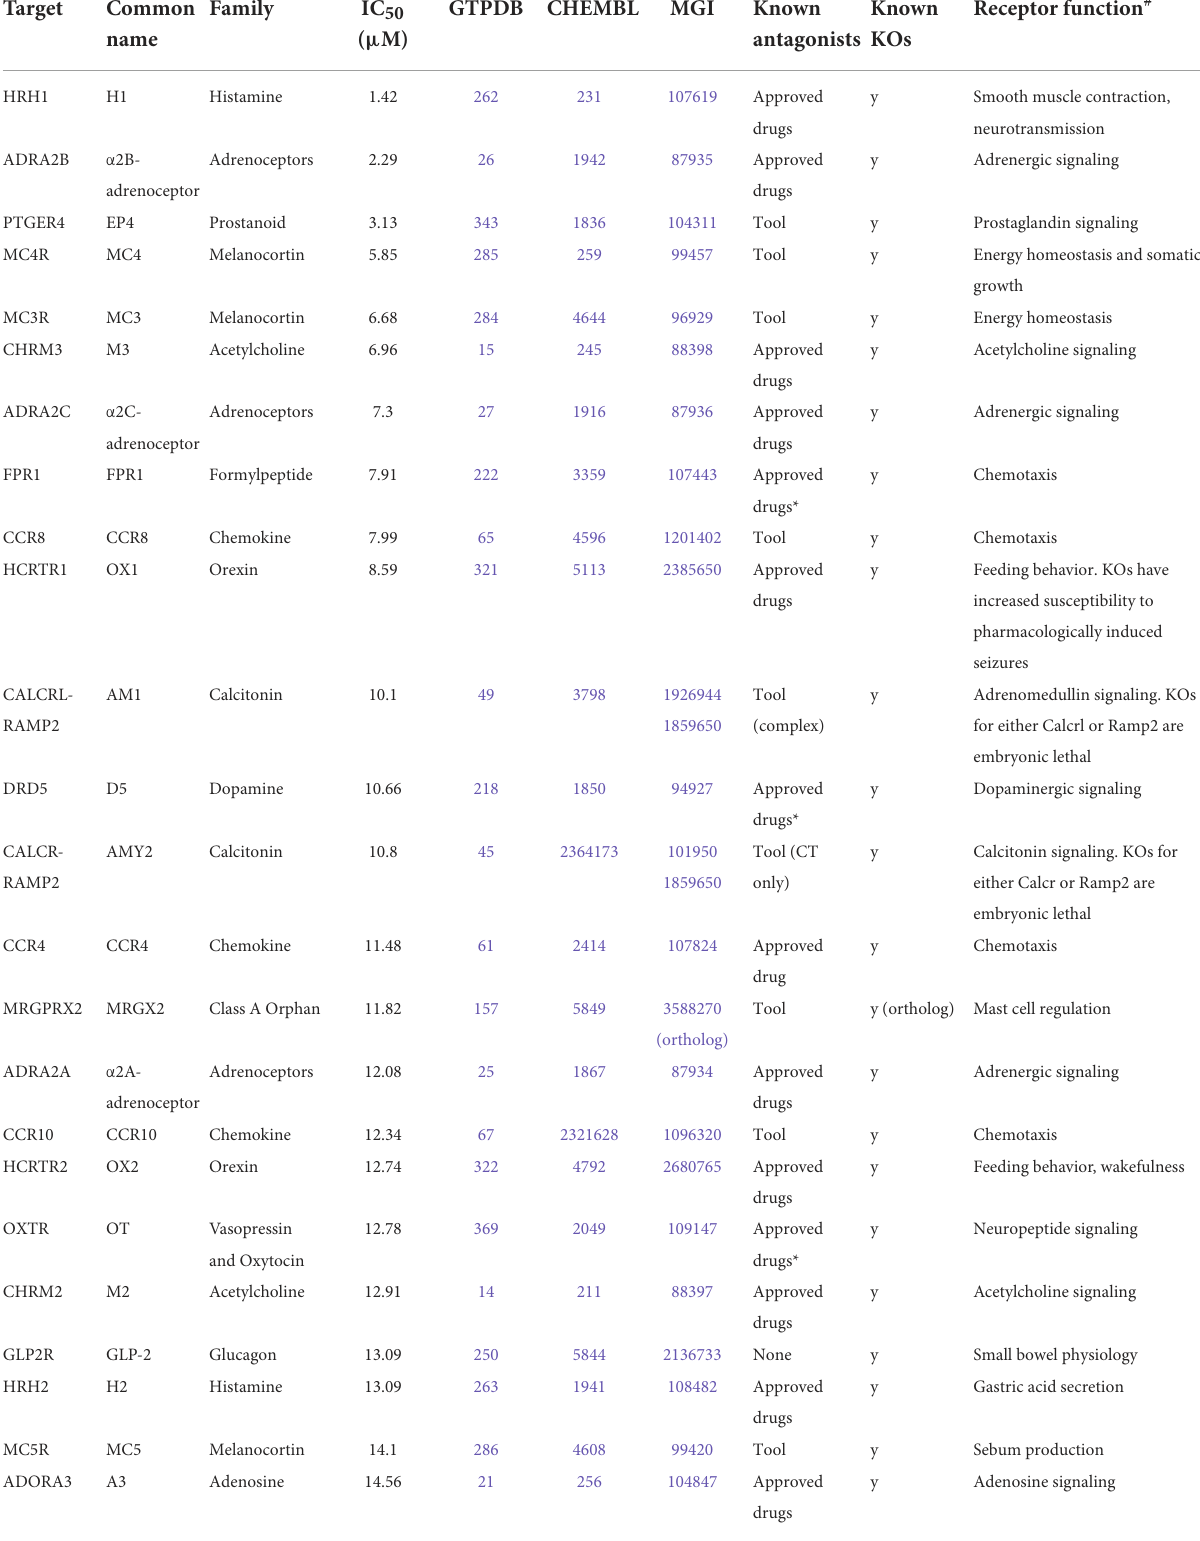
TABLE 1 Possible inhibitory off-targets of AMB-FUBINACA.